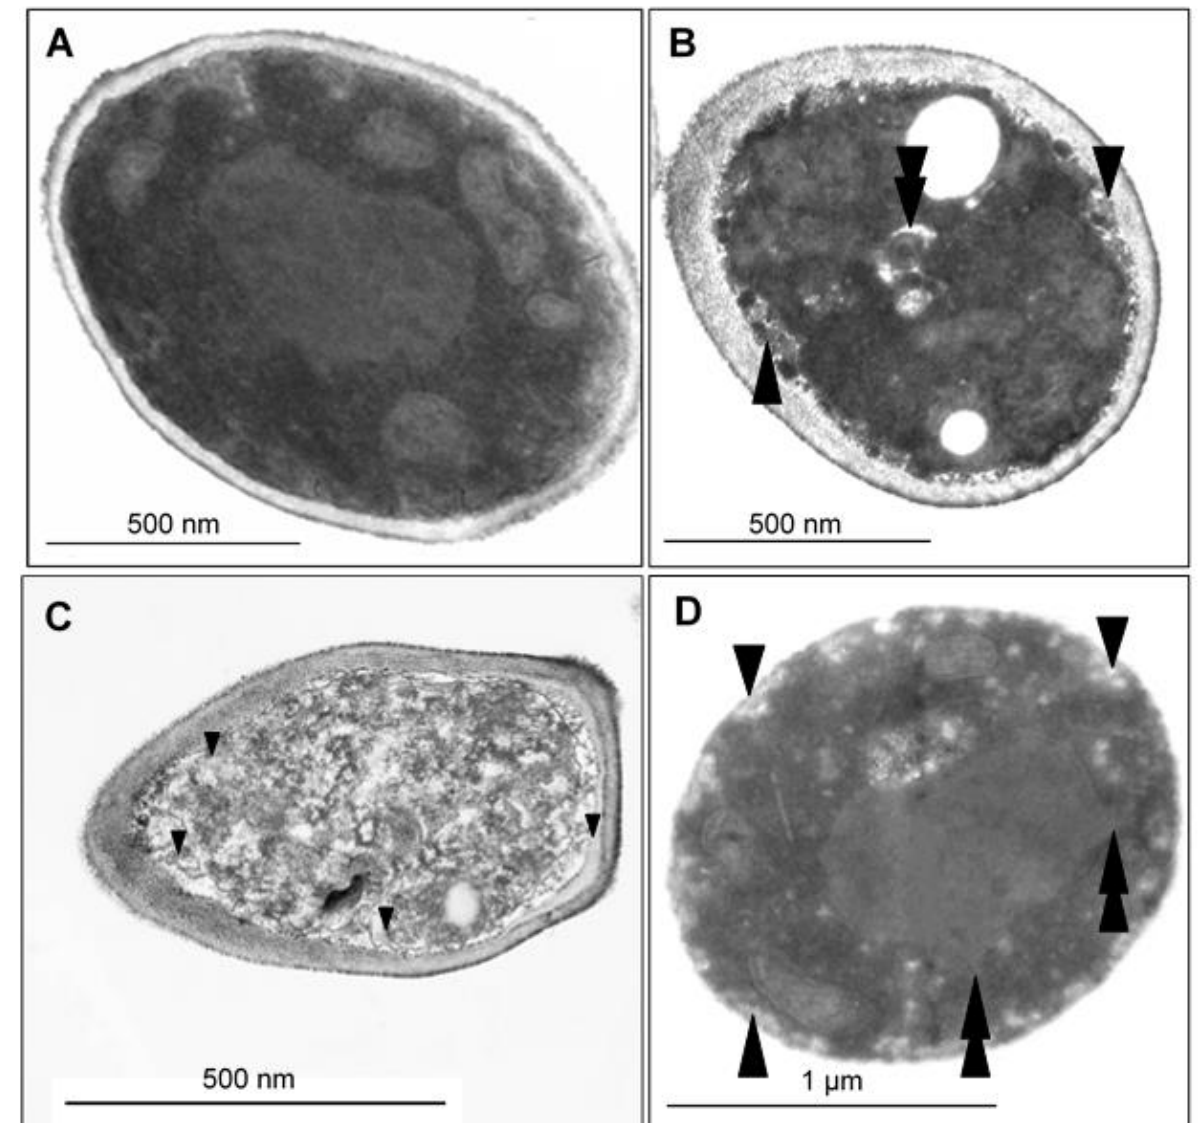
Figure 6. ( A ) TEM micrographs of the control Candida tropicalis SZMC 1366 cell structure demonstrates intact membranes, small unevenly scattered condensed chromatin grains, and homogenous cytoplasm structure. ( B – D ) TEM micrographs of C. tropicalis treated with a sub-lethal concentration of CAPE: ( B ) Late-stage disintegration with membrane fingerprints, vacuolization, plasma membrane detachment (arrowheads), and vacuole formation (double arrowheads). Fine granular homogenous cytoplasm organization disappeared, and a dense, compact cytoplasm with signs of fragmentation, rounded cell shape, and whole-cell shrinkage was seen. ( C ) Necrotic cell with membrane ruptures (arrowheads) and loss of cytoplasm density. ( D ) Several peripheral vacuoles show plasma membrane involvement (arrowheads). Nuclear bleb formation (double arrowheads).